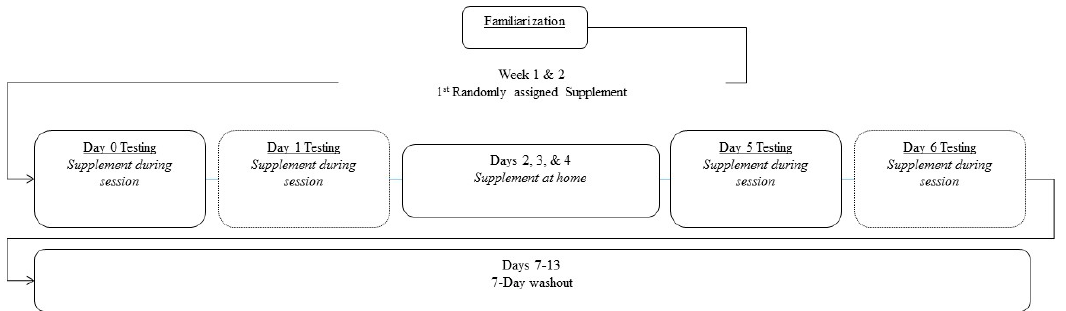
Figure 1. Overview of study design.